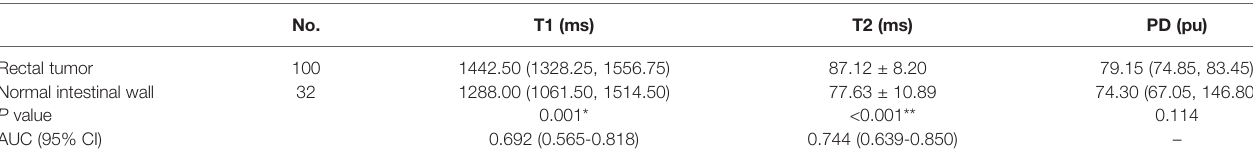
TABLE 2 | Comparison of T1, T2 and PD between rectal cancer and normal rectum.